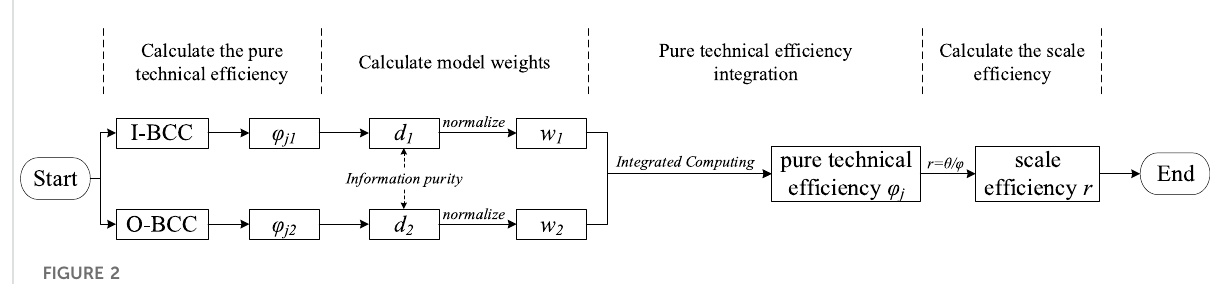
FIGURE 2 Integration of investment merger ef fi ciency evaluation.